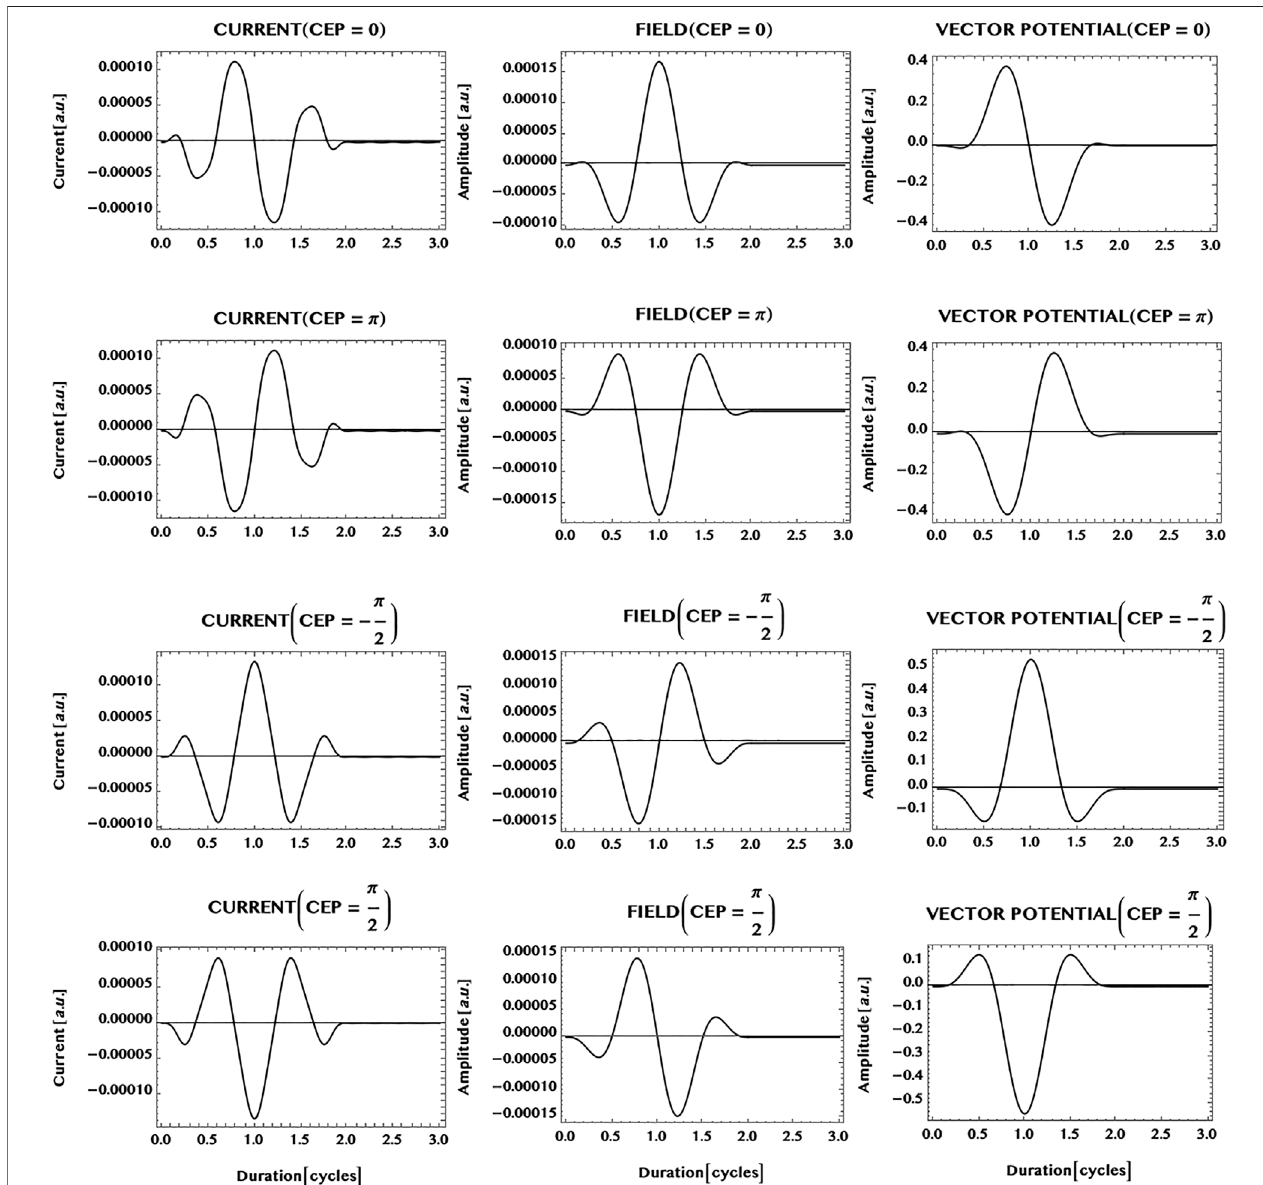
FIGURE 12 | Carrier-envelope-phase (or, CEP) dependence of an ultrashort charge-current generated in an armchair ribbon of unit width (N = 1) by an ultrashortlaserpulse(wavelength=800 nm,peak intensity=1 GW/cm 2 ,pulseduration=1.5cycles,simulationperiod=3cycles).Shownare:charge-current(LHS column); electric fi eld (middle column); the vector potential (RHS column). Note that CEP = 0 (row 1), CEP = π (row 2), CEP = - π /2 (row 3), and CEP = π /2 (row 4). It can be seen that the phase of the charge-current pulse is correlated with the CEP of the laser pulse. For example, the charge-current pulse is fully reversed by changing the CEP = 0 (row 1) to CEP = π (row 2). More generally, the shape or symmetry of the main portion of the current is seen to be similar to the shape or symmetryofthe vectorpotential ofthelaserpulse.Thissuggeststhepossibilityofshapingpulsesofcharge-carrierstoadesiredformbytailoringthe vectorpotential of the laser pulse